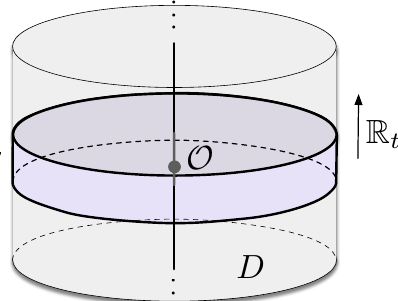
Figure 2 . The setup used to study local operators bound to vortex lines. We place the 3d theory in a solid cylinder D R t , with a vacuum boundary condition wrapping the outside, and (cid:2) a line operator along the axis. The space of local operators at a point p may be computed as O the cohomology of the moduli space of solutions to BPS equations on a \Gaussian pillbox" (or \raviolo") surrounding p